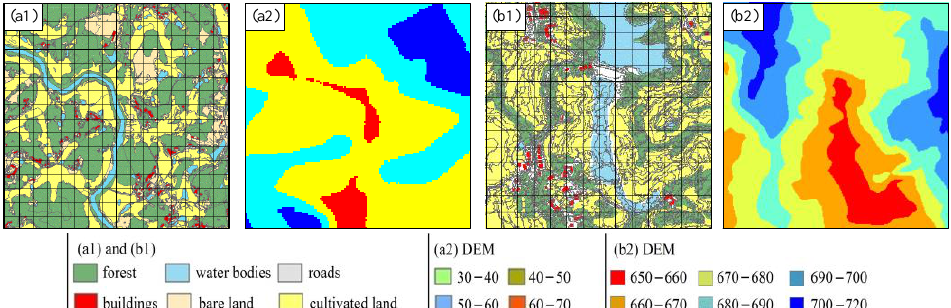
Figure 6. The results of the uniform grid and the terrain levels in the two study areas: ( a1 ) the uniform grid in the study area A; ( a2 ) the terrain levels in the study area A; ( b1 ) the uniform grid in the study area B; and ( b2 ) the terrain levels in the study area B.